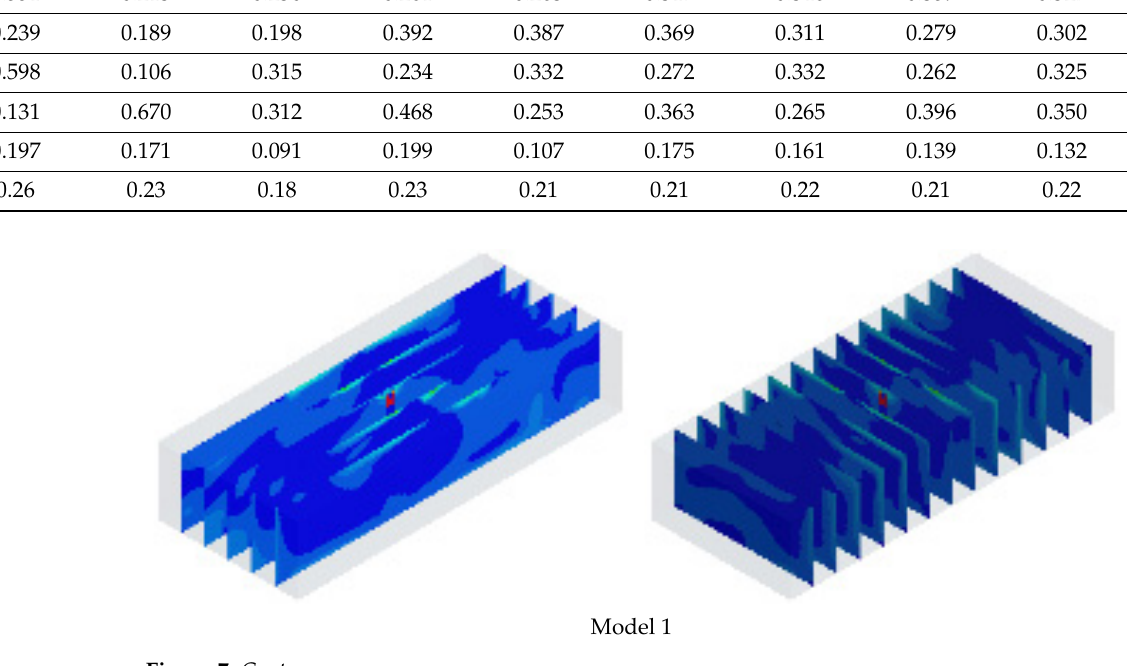
Figure 6. Air flow velocity points.